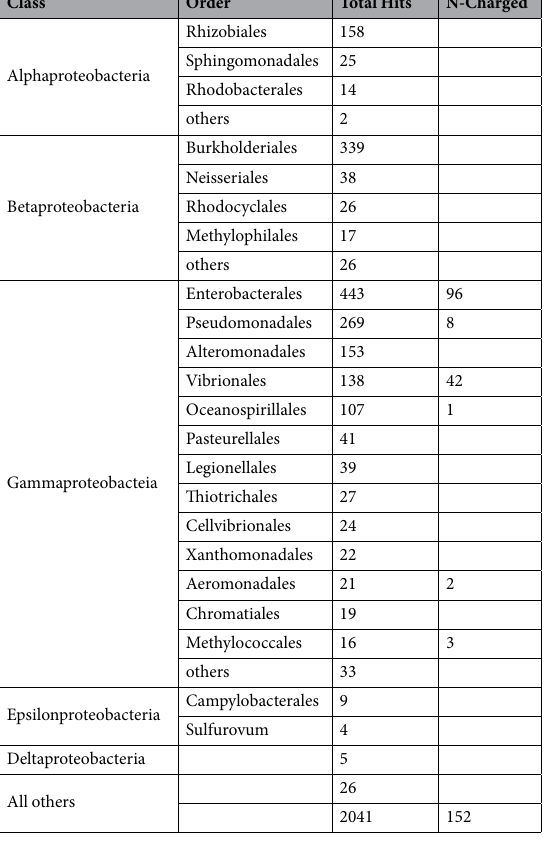
Table 1. Listed are the 2041 TatE homologues annotated as TatA. The sequences are sorted by the Class of the source strains, the number of sequences found in each Order, and the occurrence of N-terminal charges (including 108 entries with E 3 xxxxK 8 or E 2 xxxxxK 8 motifs and 44 entries with K 8